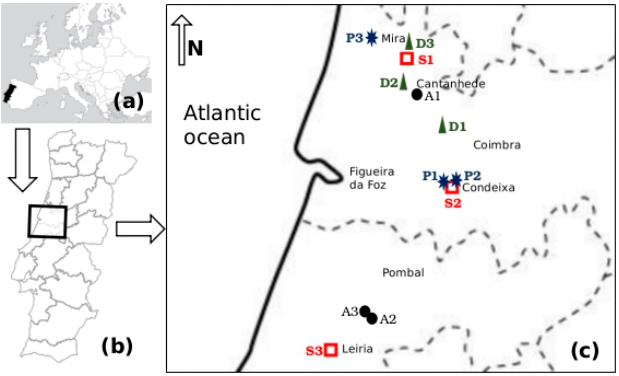
Figure 1. Location of sampling sites depicted on ( a ) a map of Europe (approximate scale 1:100,000,000, ( b ) a map of Portugal (approximate scale 1:10,000,000) and ( c ) a map of Coimbra and Leiria administrative regions (dashed lines) (approximate scale 1:1,000,000). Enterprise types are